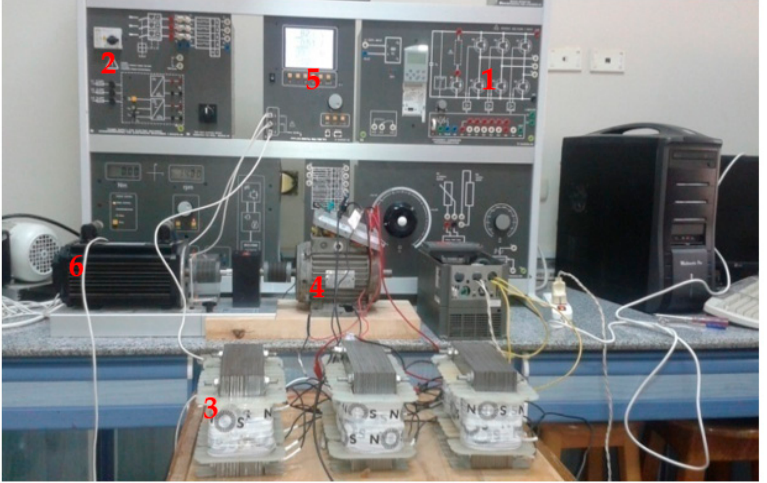
Figure 5. Block diagram of the experimental setup located in the Electrical Power Laboratory in the Faculty of Engineering, Electrical Engineering Department, Kafrelshiekh